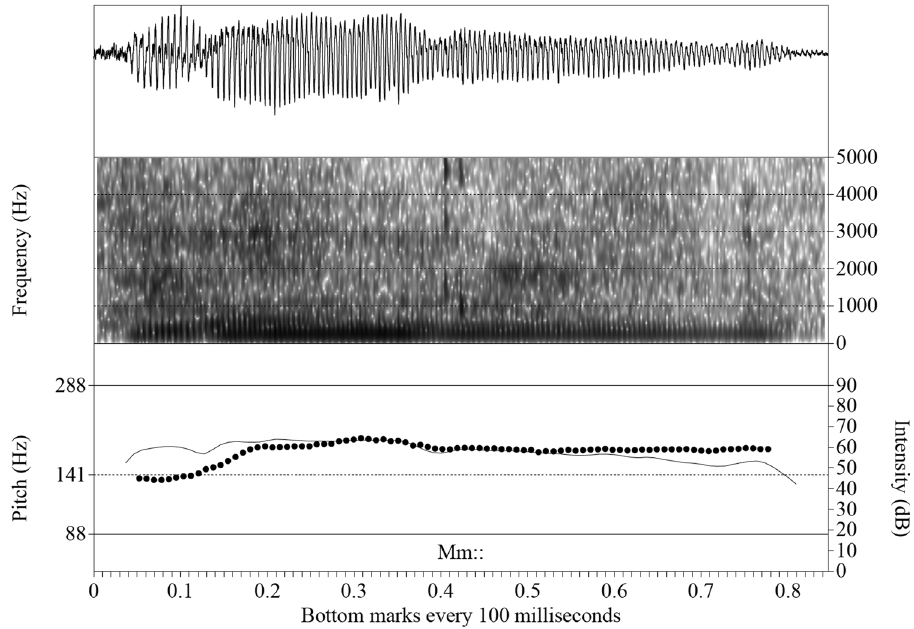
Figure 7: Waveform ( upper panel ) , spectrogram ( middle ) , and F0/intensity trace of R ’ s “ mm ” ( Example 3, line 02 ) . F0 trace scaled to L ’ s minimum/maximum F0, median marked at 141